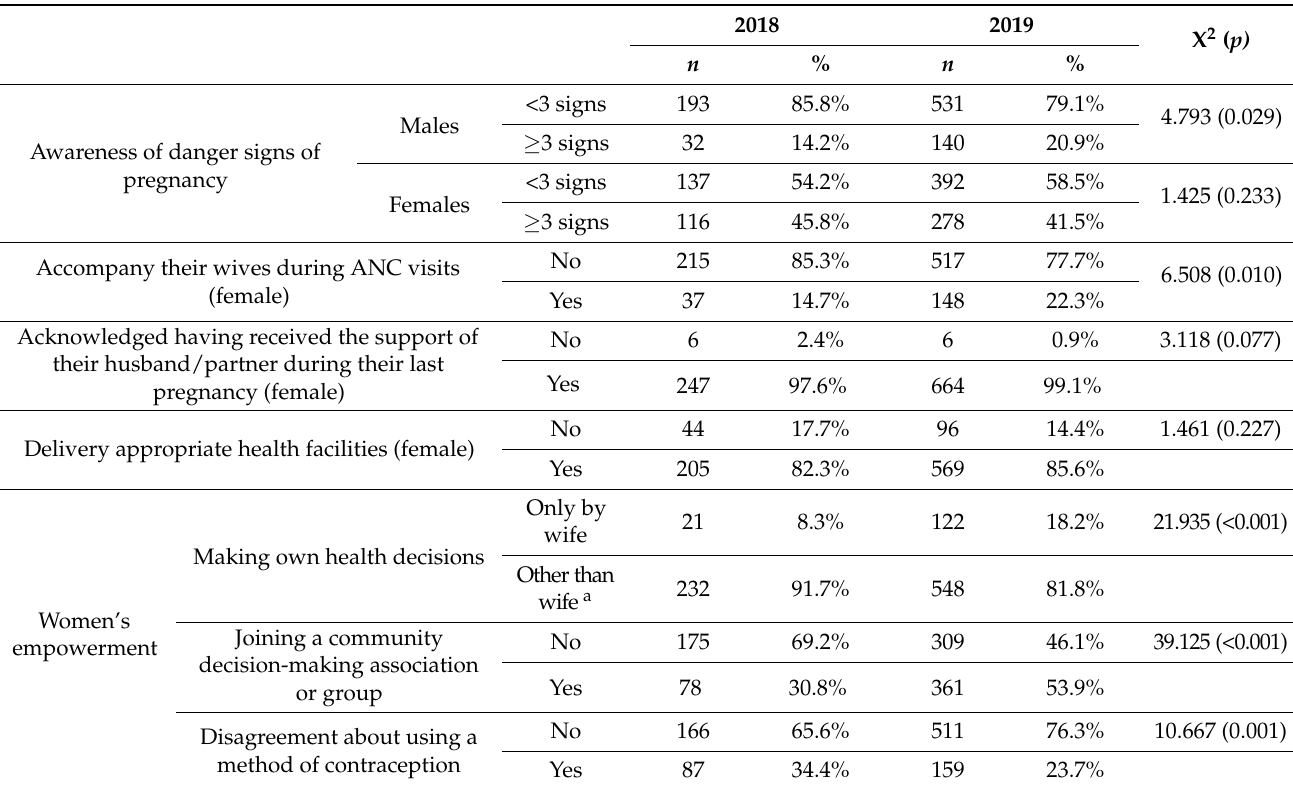
Table 3. The effects of maternal health improvement project focusing on IEC